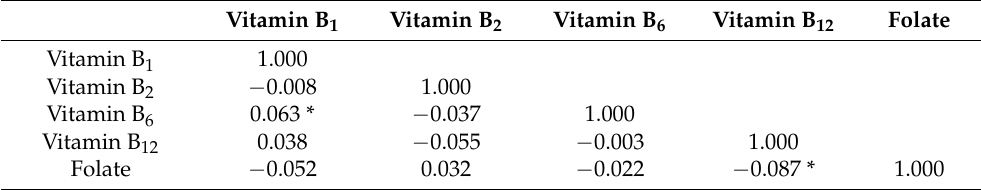
Table 3. The correlation of various serum B vitamins in the cohort study 1